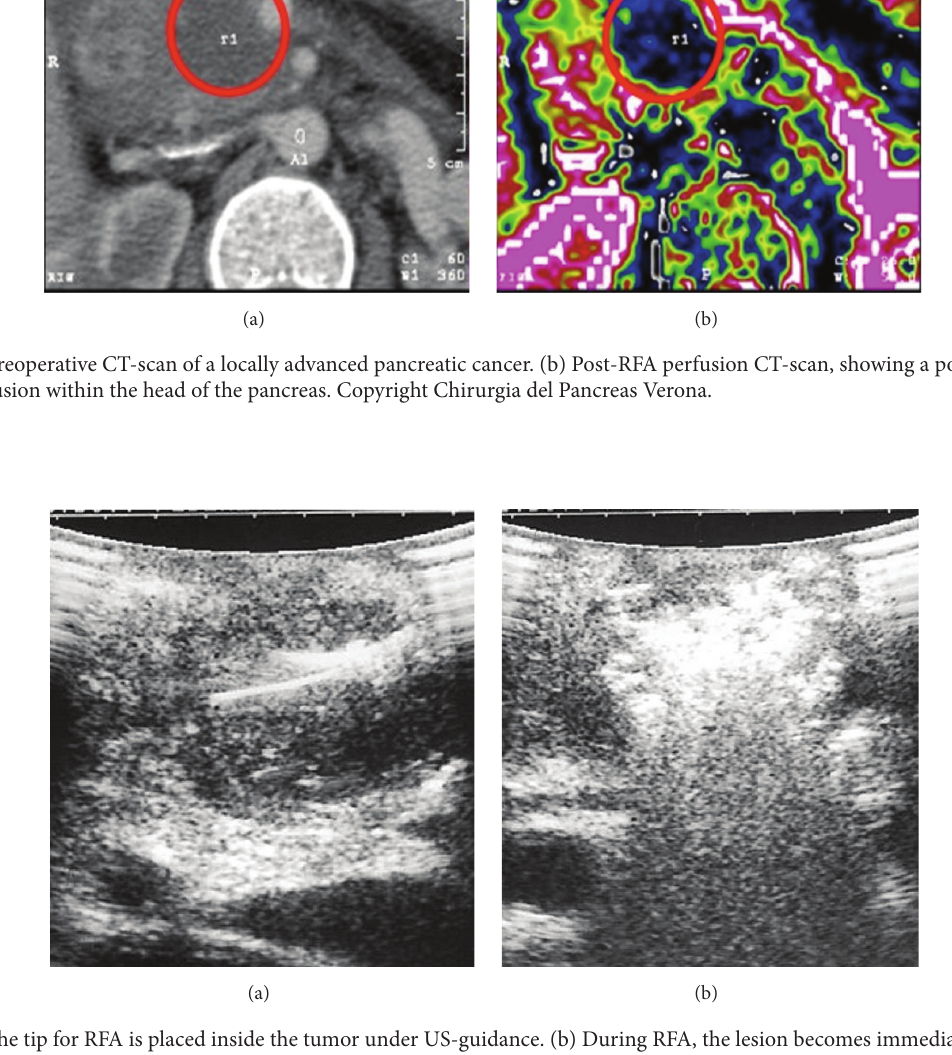
Figure 4: (a) The tip for RFA is placed inside the tumor under US-guidance. (b) During RFA, the lesion becomes immediately